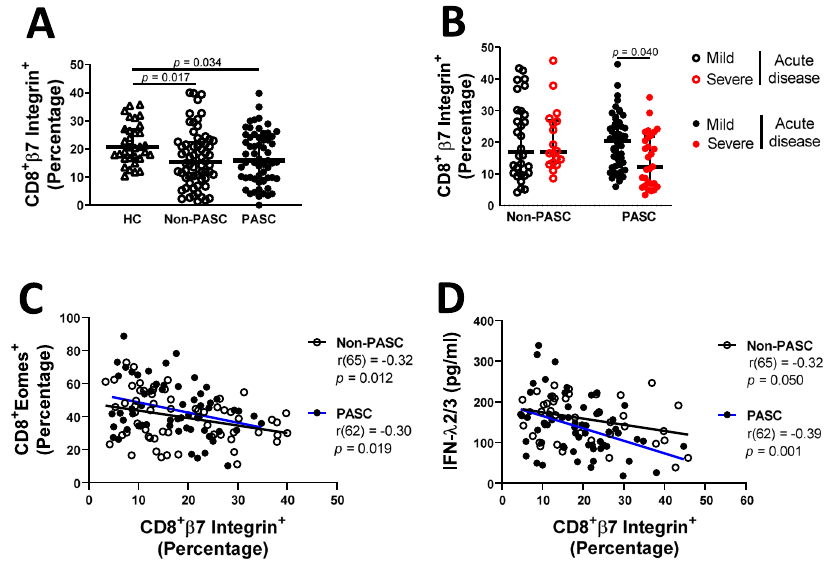
Fig. 6 | Decreased levels of Integrin + CD8 + T cells of convalescent individuals. Percentages of β 7integrin + CD8+T lymphocytes on PBMC of healthy controls ( n =37), non-PASC ( n =65) and PASC ( n =62) individuals ( A ) and sub-divided by mildorsevereacutedisease( B ).Spearman ’ scorrelationbetweenthepercentageof